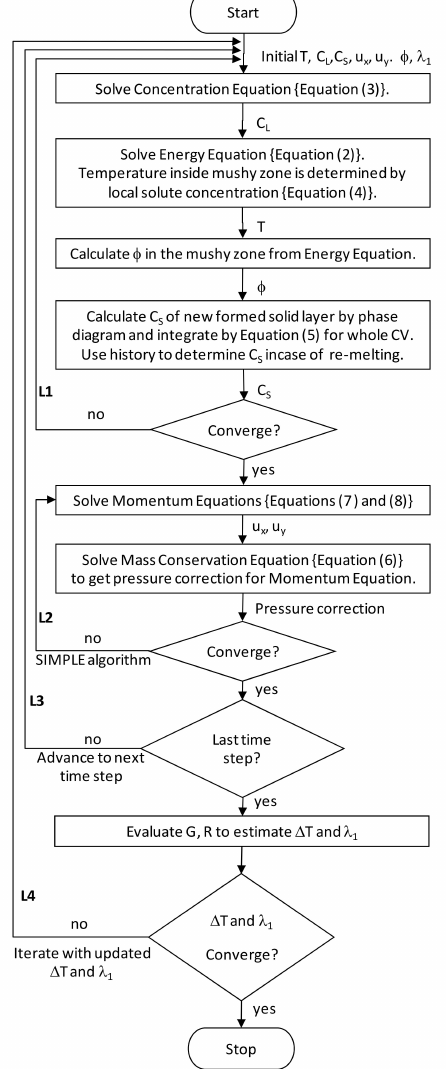
Figure 5. Numerical simulation procedure for the newly proposed